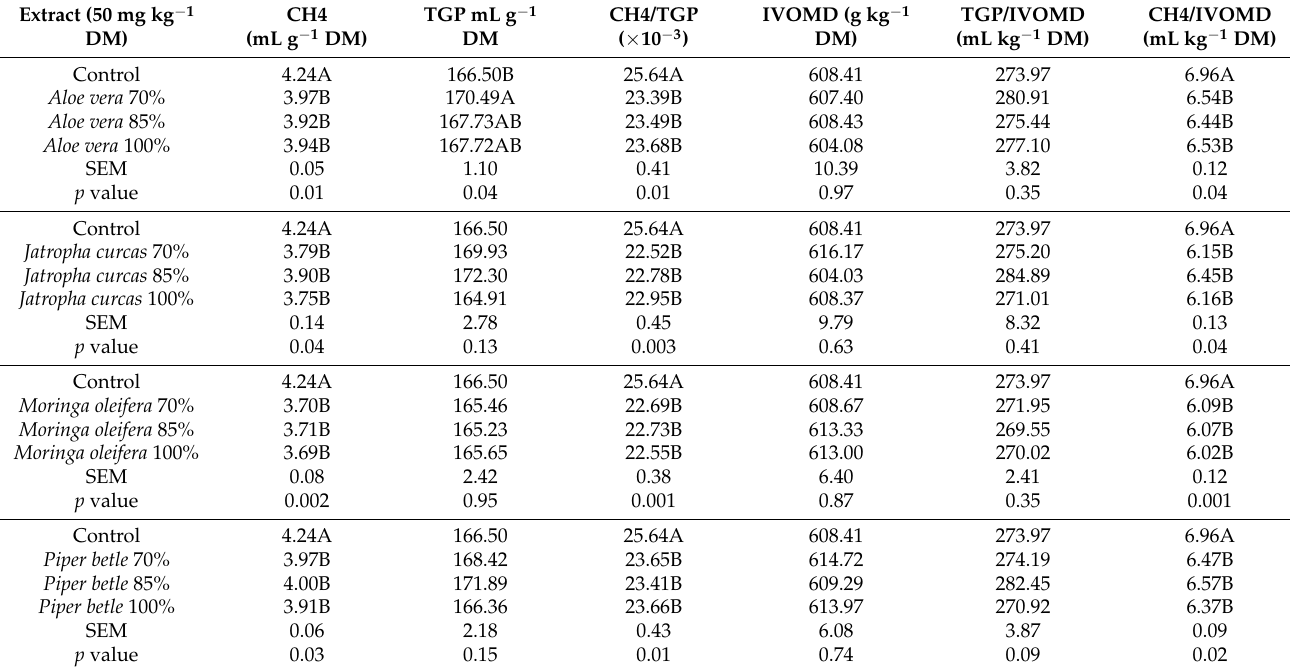
Table 6. Methane, TGP, IVOMD and their relative estimation on Eragrostis hay, as affected by the plant extract yields of three different % solvent CH 3 OH:H 2 O (70, 85, and 100%) combinations.